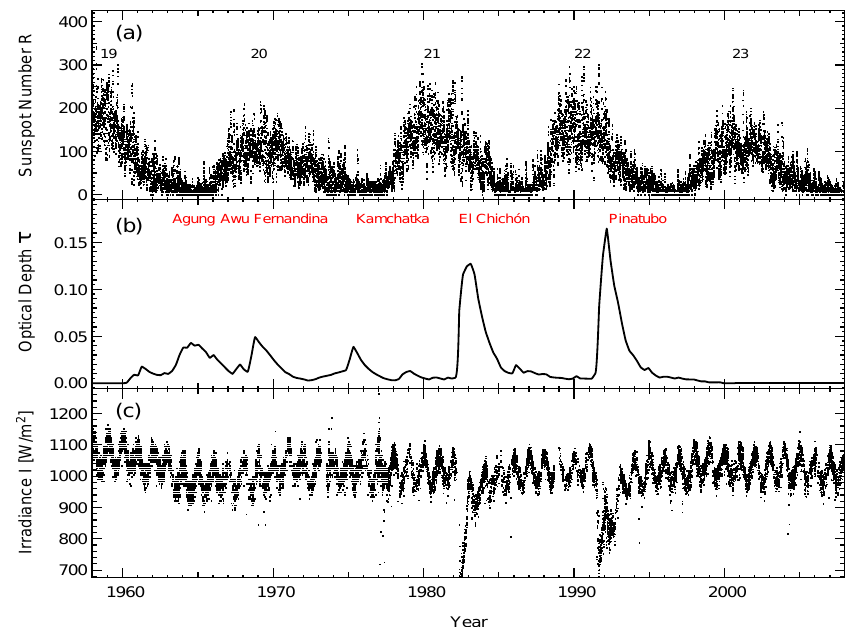
Fig. 8. Time series diagrams for (a) the daily sunspot number R for solar cycles 19 to 23, (b) the absorption by volcanic aerosols (expressed as the smoothed optical depth τ at 550 nm in the Northern Hemisphere, Sato et al., 1993), (c) the direct solar beam irradiance I (pyrheliometry) as measured from Mauna Loa at airmass 2. Note that the maximum values of the optical depth are more than a factor of ten larger than for the SAO data shown in Fig. 2. Prominent volcanic eruptions are